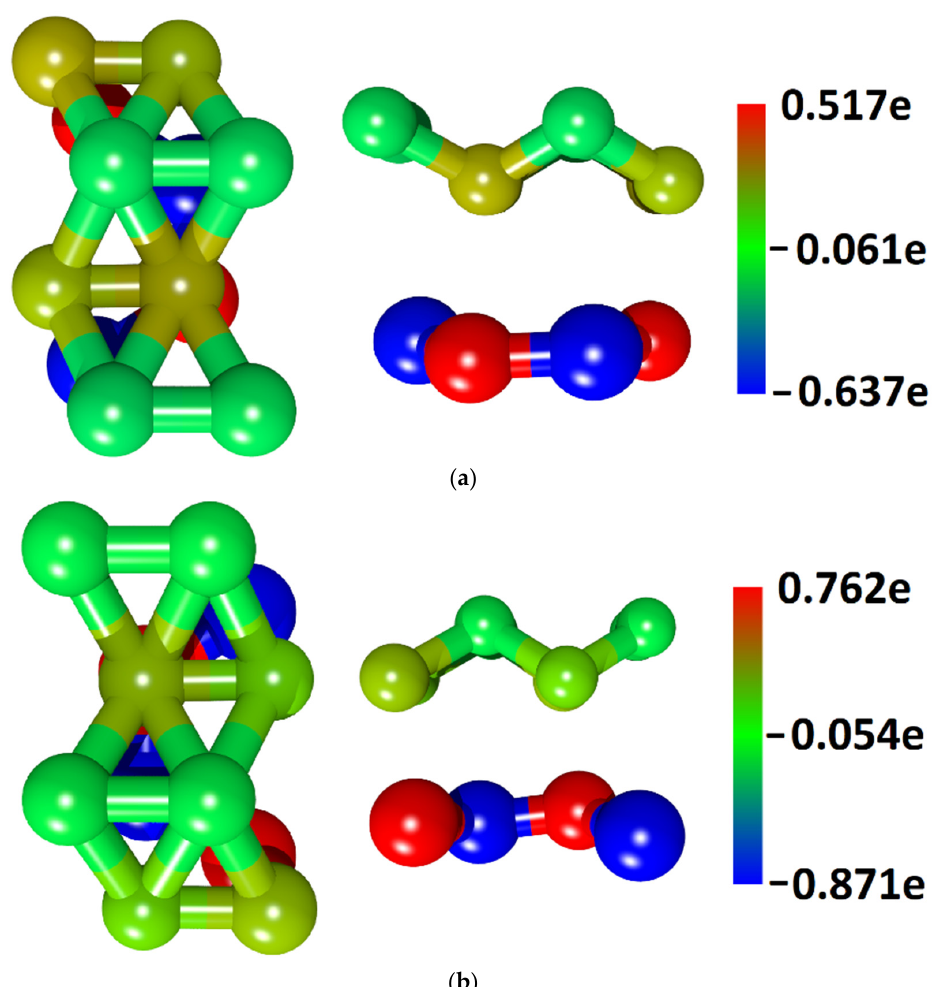
Figure 4. Distribution of electron charge density over atoms of supercells of borophene/GaN ( a ) and borophene/ZnO ( b ) van der Waals heterostructures.